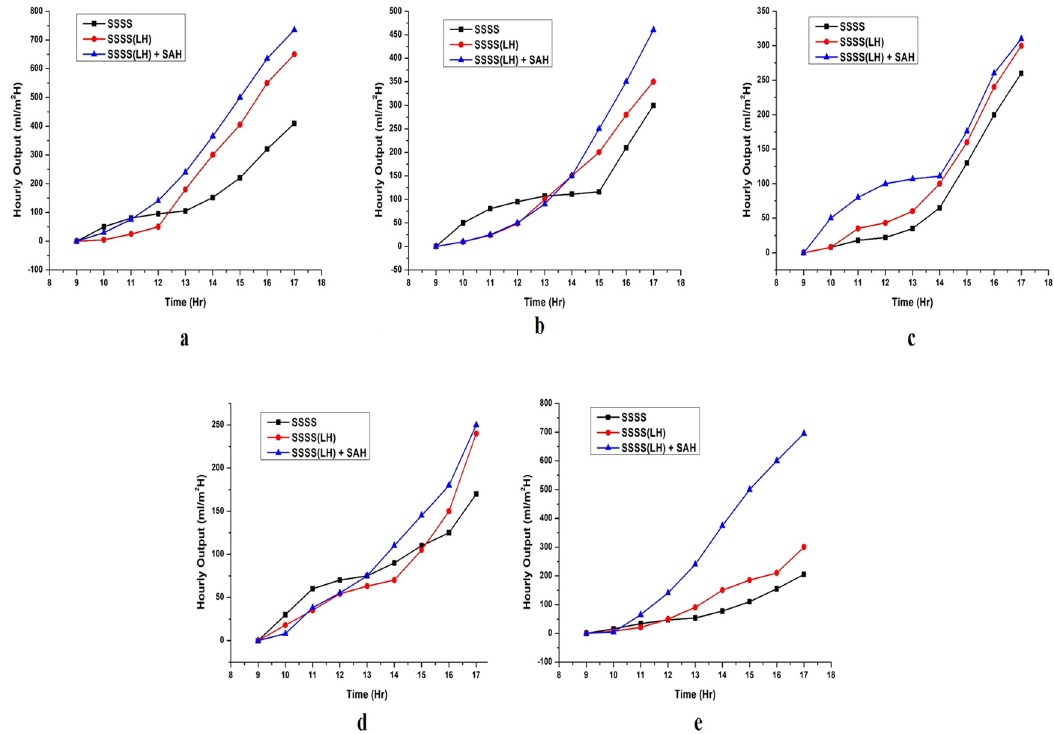
Figure 7. ( a – e ) Variation of hourly output vs. time at the depth of 3 cm, 6 cm, 9 cm, 12 cm, and 15 cm, respectively.